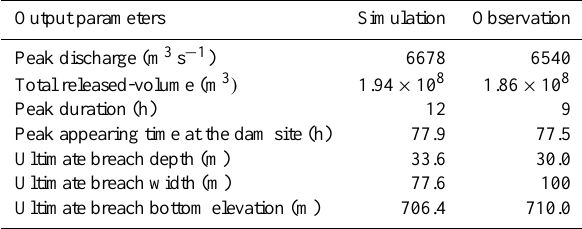
Table 3. The BREACH model calibration results. The peak duration represents the lasted time for the discharge being over 1000m 3 s − 1 ; the peak appearing time is referred to the time from the first flow released through the spillway till the peak arrived; and the total re- leased volume includes not only the lake volume but also the inflow volume during the